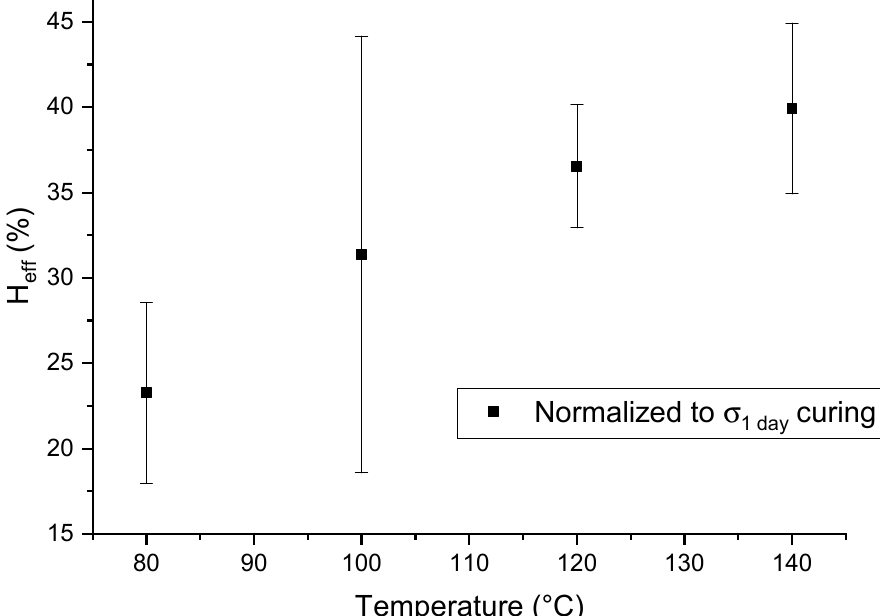
Figure A4. Temperature-dependency of healing efficiency with standard deviation. With increased temperature, a higher mobility is generated leading to higher healing efficiencies. All measurements were performed after three days.